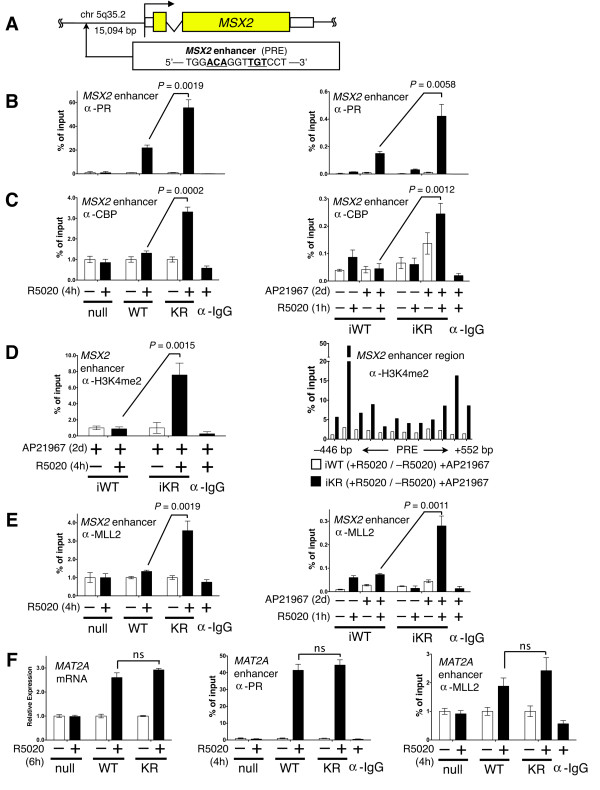
Promoter selectivity is achieved through increased recruitment of SUMO-deficient KR PR, CBP, MLL2 and histone tail modification, H3K4me2, to enhancer loci. (A) Schematic showing the MSX2 gene PRE-containing enhancer region located 15,094 bp upstream from the transcriptional start site. (B) Relative recruitment of PR to the MSX2 enhancer region was measured by ChIP-qPCR assays in T47D cells expressing constitutive PR null, WT or KR PR after treatment with R5020 for one or four hours. PR recruitment values were normalized as a percentage of input chromatin DNA values. To control for background non-specific antibody binding, immunoprecipitated chromatin contained a mixture from all samples with an IgG antibody. Similar ChIP results were obtained in T47D cells expressing inducible PR (right side). (C) The relative recruitment of CBP to the MSX2 enhancer region was measured as described in part B. (D) Levels of H3K4 dimethylation at the MSX2 enhancer were measured in the inducible PR expressing cell lines (iWT and iKR). The presence of H3K4me2 was determined at the MSX2 enhancer, up/downstream from the PRE, using overlapping qPCR products that span the region. (E) MLL2 recruitment to the MSX2 enhancer region was determined in T47D cells expressing both constitutive PR and inducible PR, as described in part B. (F) MAT2A gene expression was measured by RT-qPCR in T47D cells expressing stable WT or SUMO-deficient KR PR. Additionally, PR and MLL2 recruitment was quantified in these cells, as measured by standard ChIP-qPCR assay. Data are represented as mean of n = 3 +/- SD and significance calculated using Student's t-test. [See also Additional files 7, 5. KR, K388R PR-B mutant]. CBP, CREB-(cAMP-response element-binding protein)-binding protein; ChIP, chromatin immunoprecipitation; H3K4me2, histone H3 lysine 4 dimethylation; IgG, immunoglobulin G; KR, K388R PR-B mutant; MLL2, mixed lineage leukemia 2; PR, progesterone receptor; PRE, progesterone receptor response element; SD, standard deviation; SUMO, small ubiquitin-like modifier; WT, wild type.